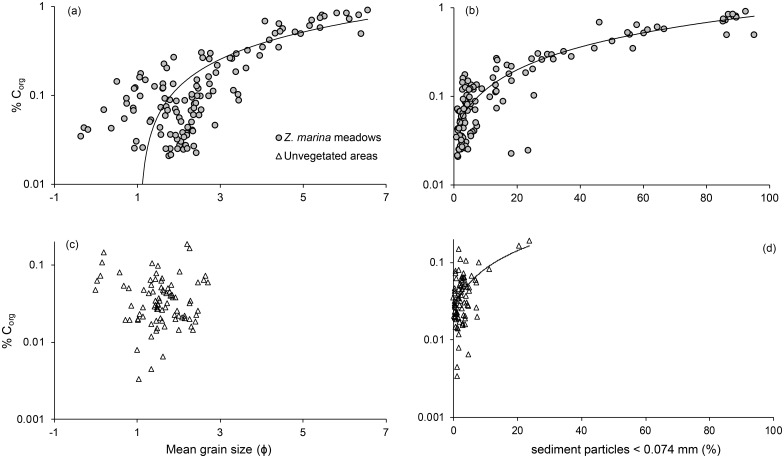
Semi-log plots (log10[x+1]) showing the relationship between sedimentary % Corg and grain size.The % Corg is presented with a log scale as it gave the best fit of the models. Grain size is shown as mean grain size (ɸ) and sediment particles < 0.074 mm (%) for Z. marina meadows (a and b) and unvegetated areas (c and d). The % Corg was positively linked to both sediment particles < 0.074 mm (%) (R2 = 0.91, P < 0.001) and mean grain size (ɸ) (R2 = 0.74, P < 0.001) for Z. marina meadows but for unvegetated areas only sediment particles < 0.074 mm (%) showed such relationship with % Corg (R2 = 0.42, P < 0.001).